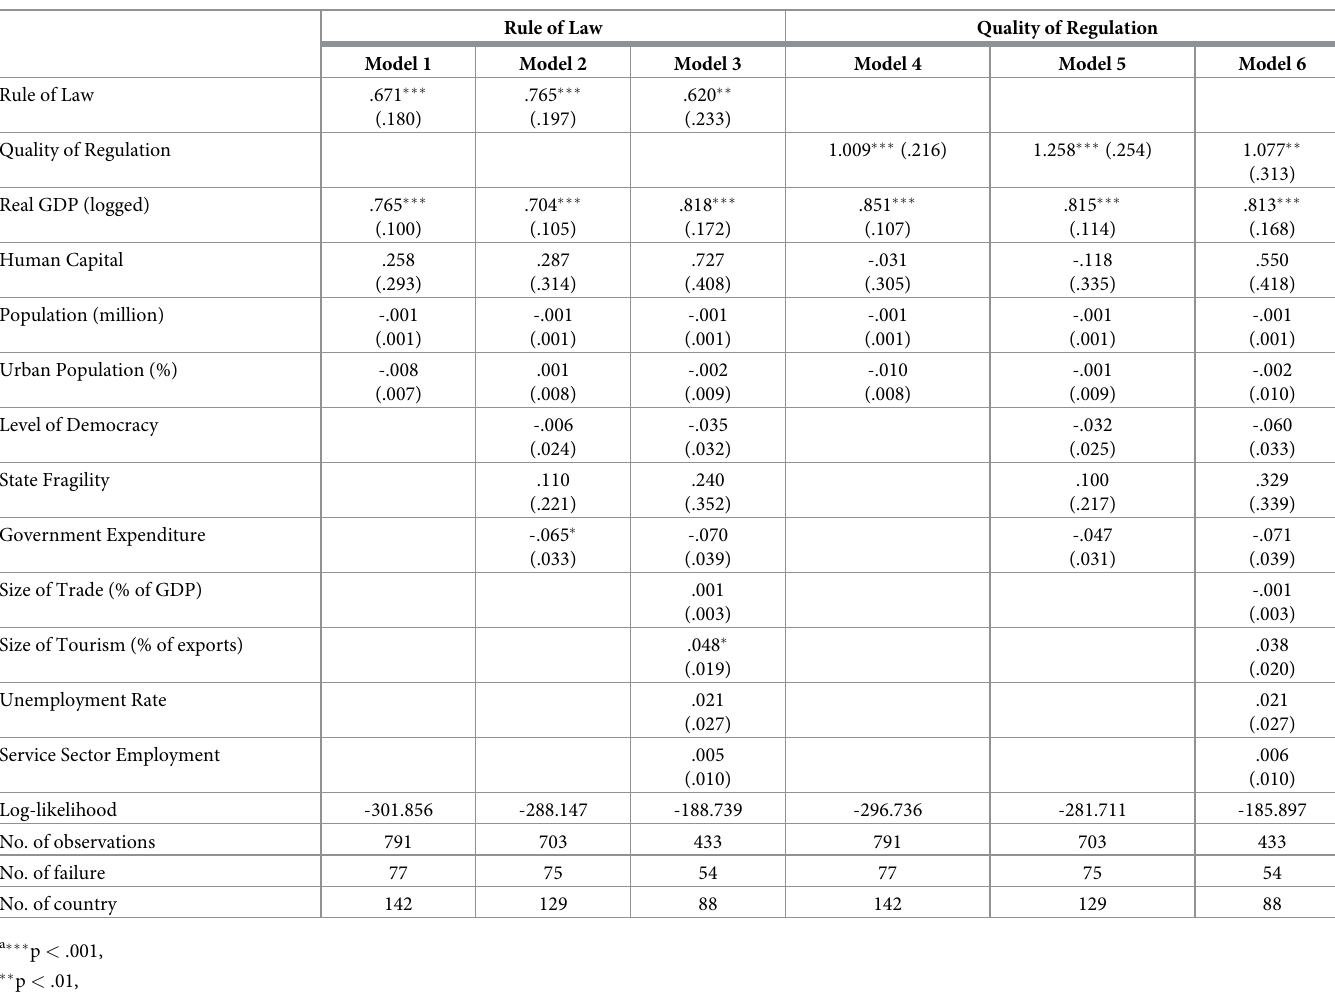
Table 3. Hazard estimation for the international diffusion of